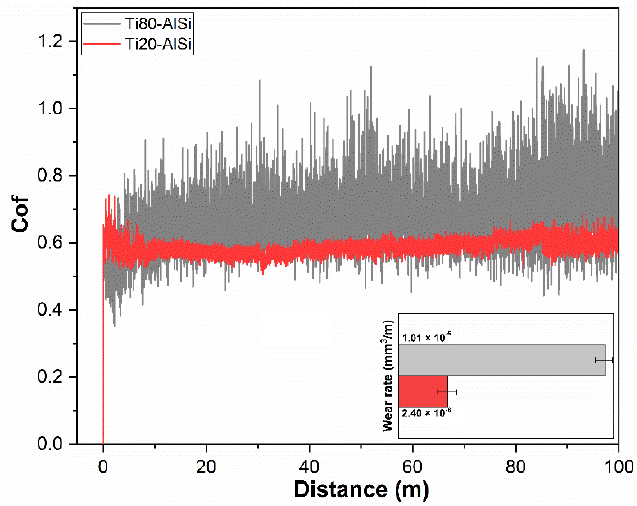
Figure 2. Coefficient of friction and wear rate against a WC–6Co ball for the two materials Ti80–AlSi and